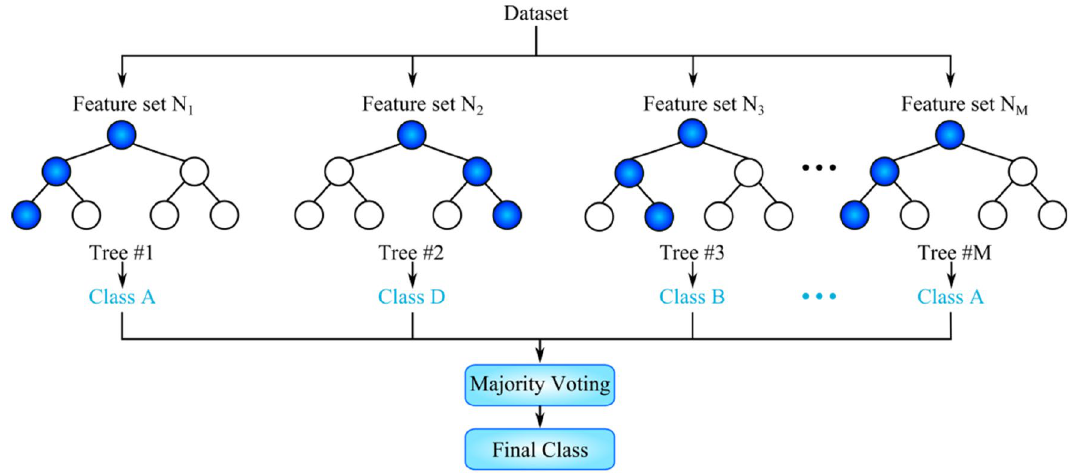
Figure 2. Schematic of a random forest with M number of decision trees. The final classification is determined by majority voting of the classification results of individual decision